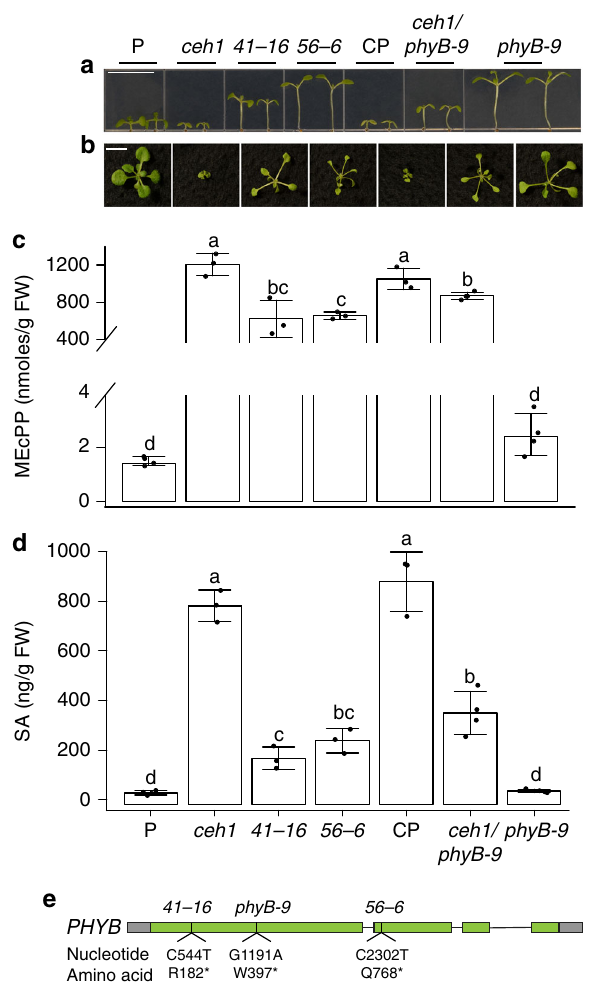
Fig. 1 PhyB is a component of MEcPP signal transduction pathway. a , b Representative images of 1-week-old and 2-week-old P, ceh1 , 41-16 , 56-6 , complementation line (CP), ceh1 / phyB-9 , and phyB-9 seedlings grown in long-day (LD; 16 h light/8 h dark), respectively. c MEcPP measurements of 2-week-old seedlings of aforementioned genotypes. The white line indicates a change of scale on the Y axis. d Measurements of Salicylic Acid (SA) levels of samples used in ( c ). e Schematic illustration of PHYB gene. Green boxes represent exons, gray boxes represent UTRs, the actual nucleotide and amino acid changes of the mutants are displayed underneath. Data are mean ± SD, each genotype with at least three biological replicates. Letters above bars indicate signi fi cant differences determined by Tukey ’ s HSD method ( P < 0.05). Scale bar: 1